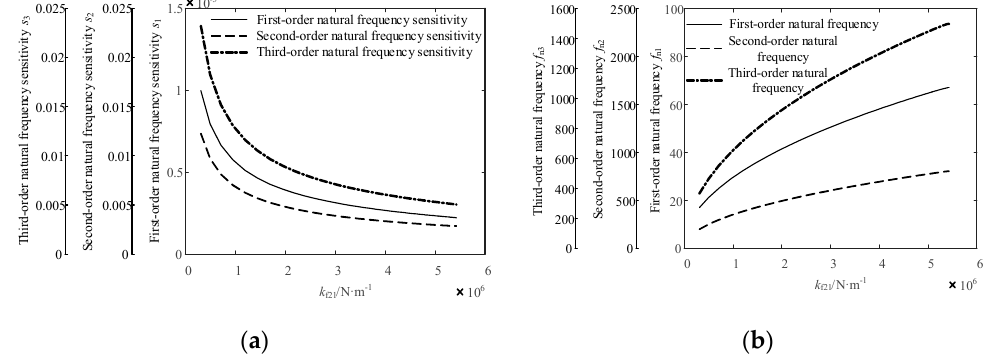
Figure 13. The variation law of the first three natural frequencies and their sensitivities of the jet system under a different pressure of the fluid with the stiffness of fluid unit 2. ( a ) Variation law of natural frequency sensitivity. ( b ) Variation law of natural frequency.